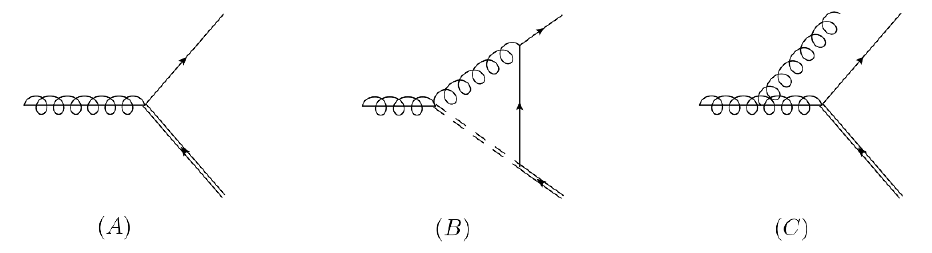
within the coloron 1